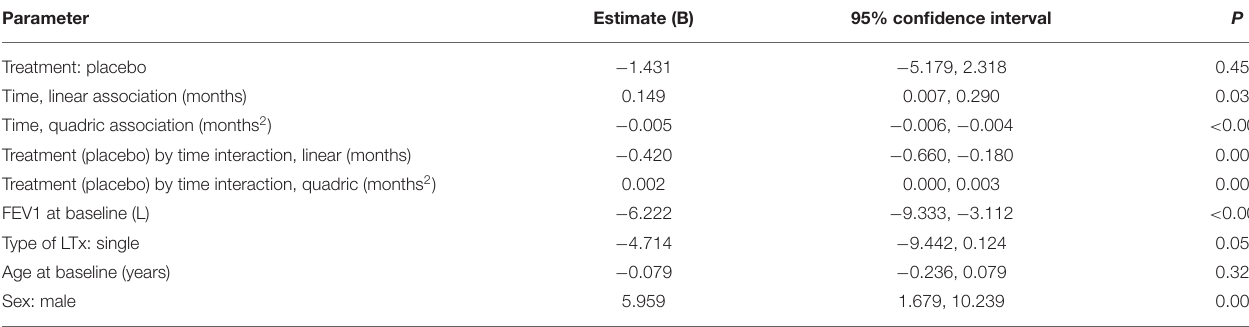
TABLE 2 | Association between FEV1 % of baseline value time course and various predictors—linear mixed model main results. Parameter